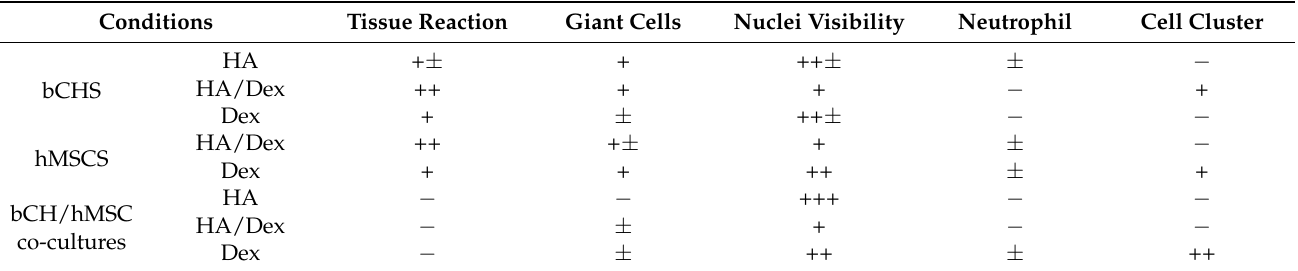
Table 1. Histological scoring of the in vivo